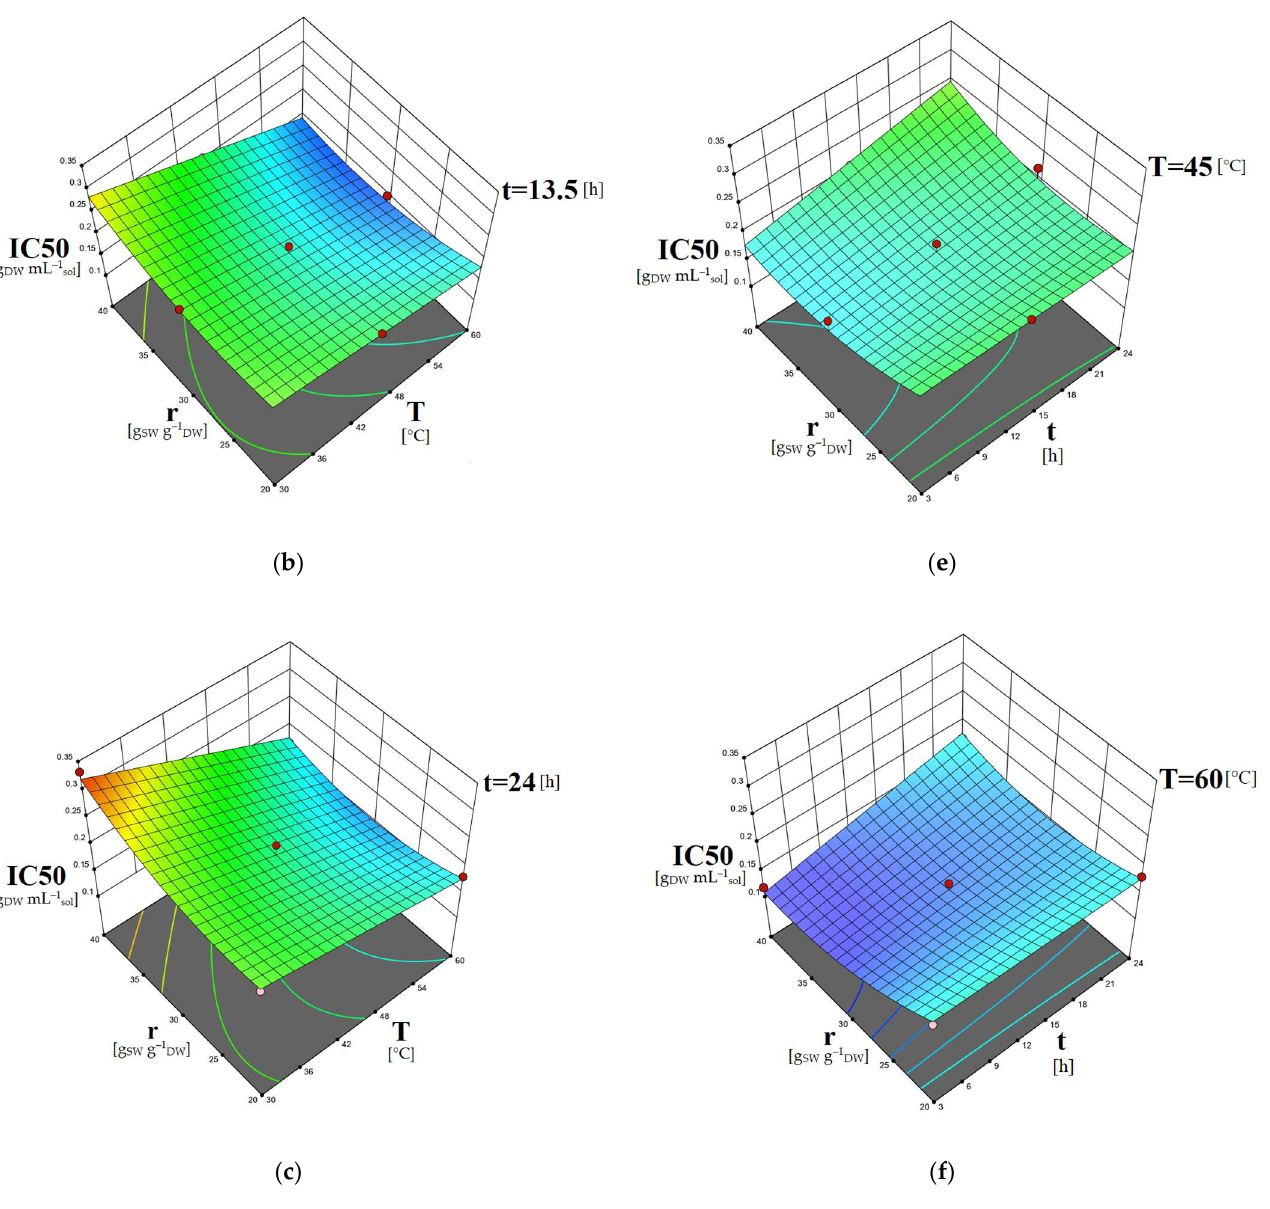
Figure 3. Three-dimensional surface plots showing the combined effects of ( a – c ) temperature and solvent-to-biomass ratio and ( d – f ) time and solvent-to-biomass ratio on the IC50 [g DW mL –1 sol ] of the C. vulgaris extracts obtained using DES1/w solvent.